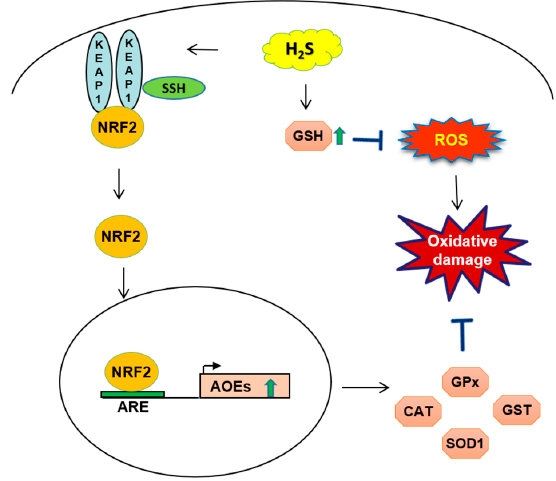
Figure 2. Schematic of H 2 S mechanism related to glutathione GSH and nuclear factor (erythroid-derived 2)-like 2 NRF2 targets in oxidative cell-damage. The endogenous release of H 2 S increases GSH synthesis and blocks reactive oxygen species ROS production. When the cellular level of H 2 S is increased, Kelch-like ECH-associated protein 1 Keap1 protein is S-sulfhydrated SSH: which brings a conformational change of the protein and NRF2 release from Keap1 . NRF2 translocates to the nucleus, binding to the promoter containing antioxidant response element (ARE) sequences and increased transcription of antioxidant genes as catalase CAT , superoxide dismutase SOD1 , and glutathione-S-transferase GST , glutathione peroxidase GPx . AOE: antioxidant enzyme.